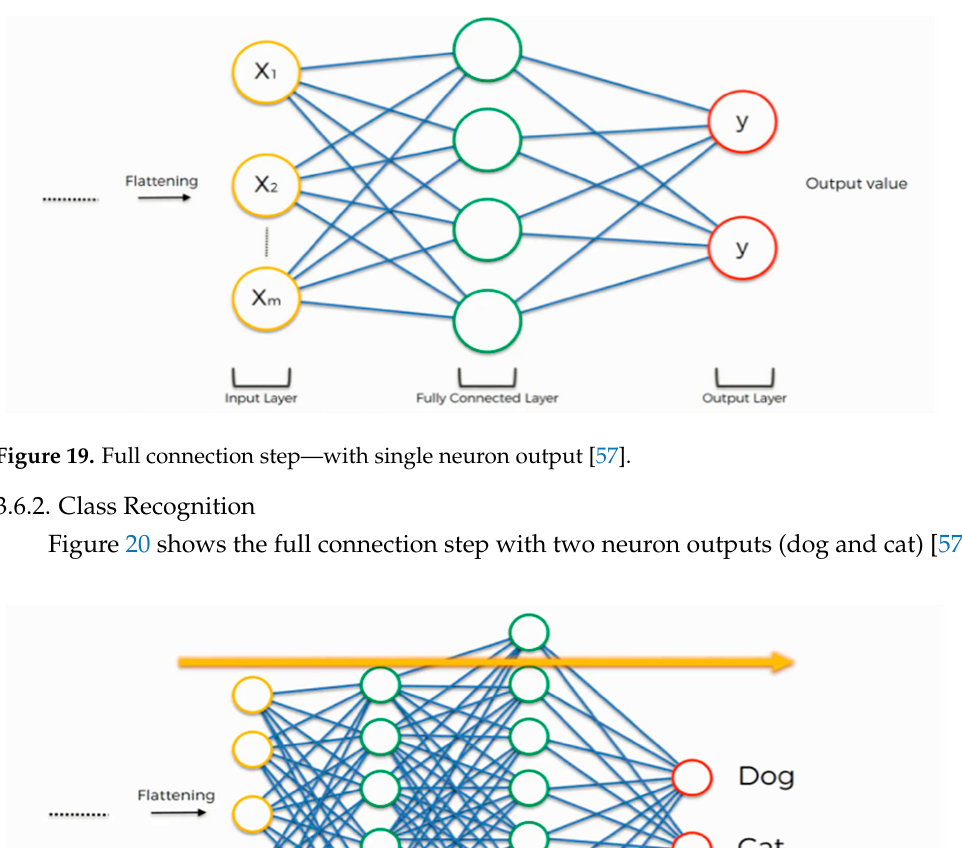
24 of 56 Figure 18. Flattening the pooled feature map [57]. Step 4: Full Connection The purpose of the artificial neural network is to make the convolutional network more capable of classifying images. The artificial neural network’s role is to take the data that were created in the flattening step and combine the features into a wider variety of attributes to achieve its aforementioned purpose. There are three layers in the full connection step: the input layer, the fully connected layer (in this context called a hidden layer in artificial neural networks), and the output layer. The neural network issues its predictions for the processed input image that passes through it. Assume that the actual image is a cat, but the network predicts that the figure in the image is a dog with a probability of 80%. A calculation of the error should be carried out. This is defined as a “loss function” or a mean squared error. The importance of the loss